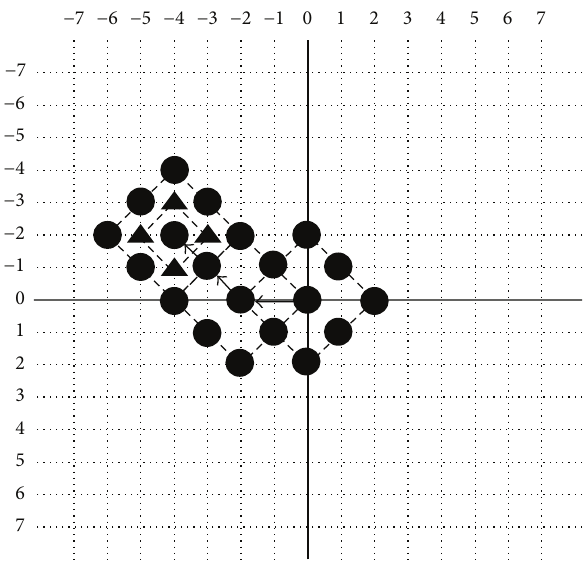
Figure 6: Search path